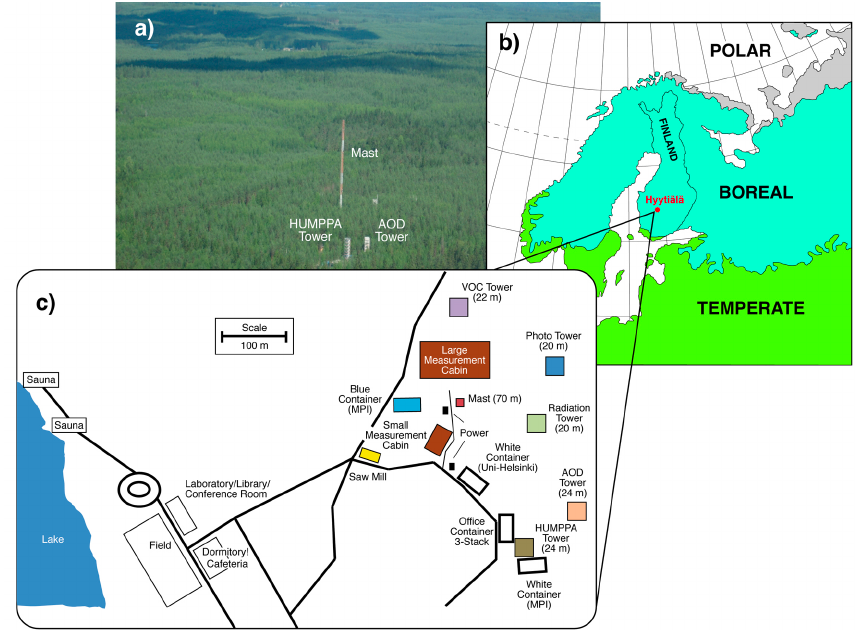
Fig. 1. This Fig. is a composite of (a) an aerial view taken during the campaign of the Hyyti¨al¨a site looking northwest, (b) a map of the bioclimatically defined Boreal region of Europe, and (c) a local map of the site showing locations of instruments and towers (see also Table 1).